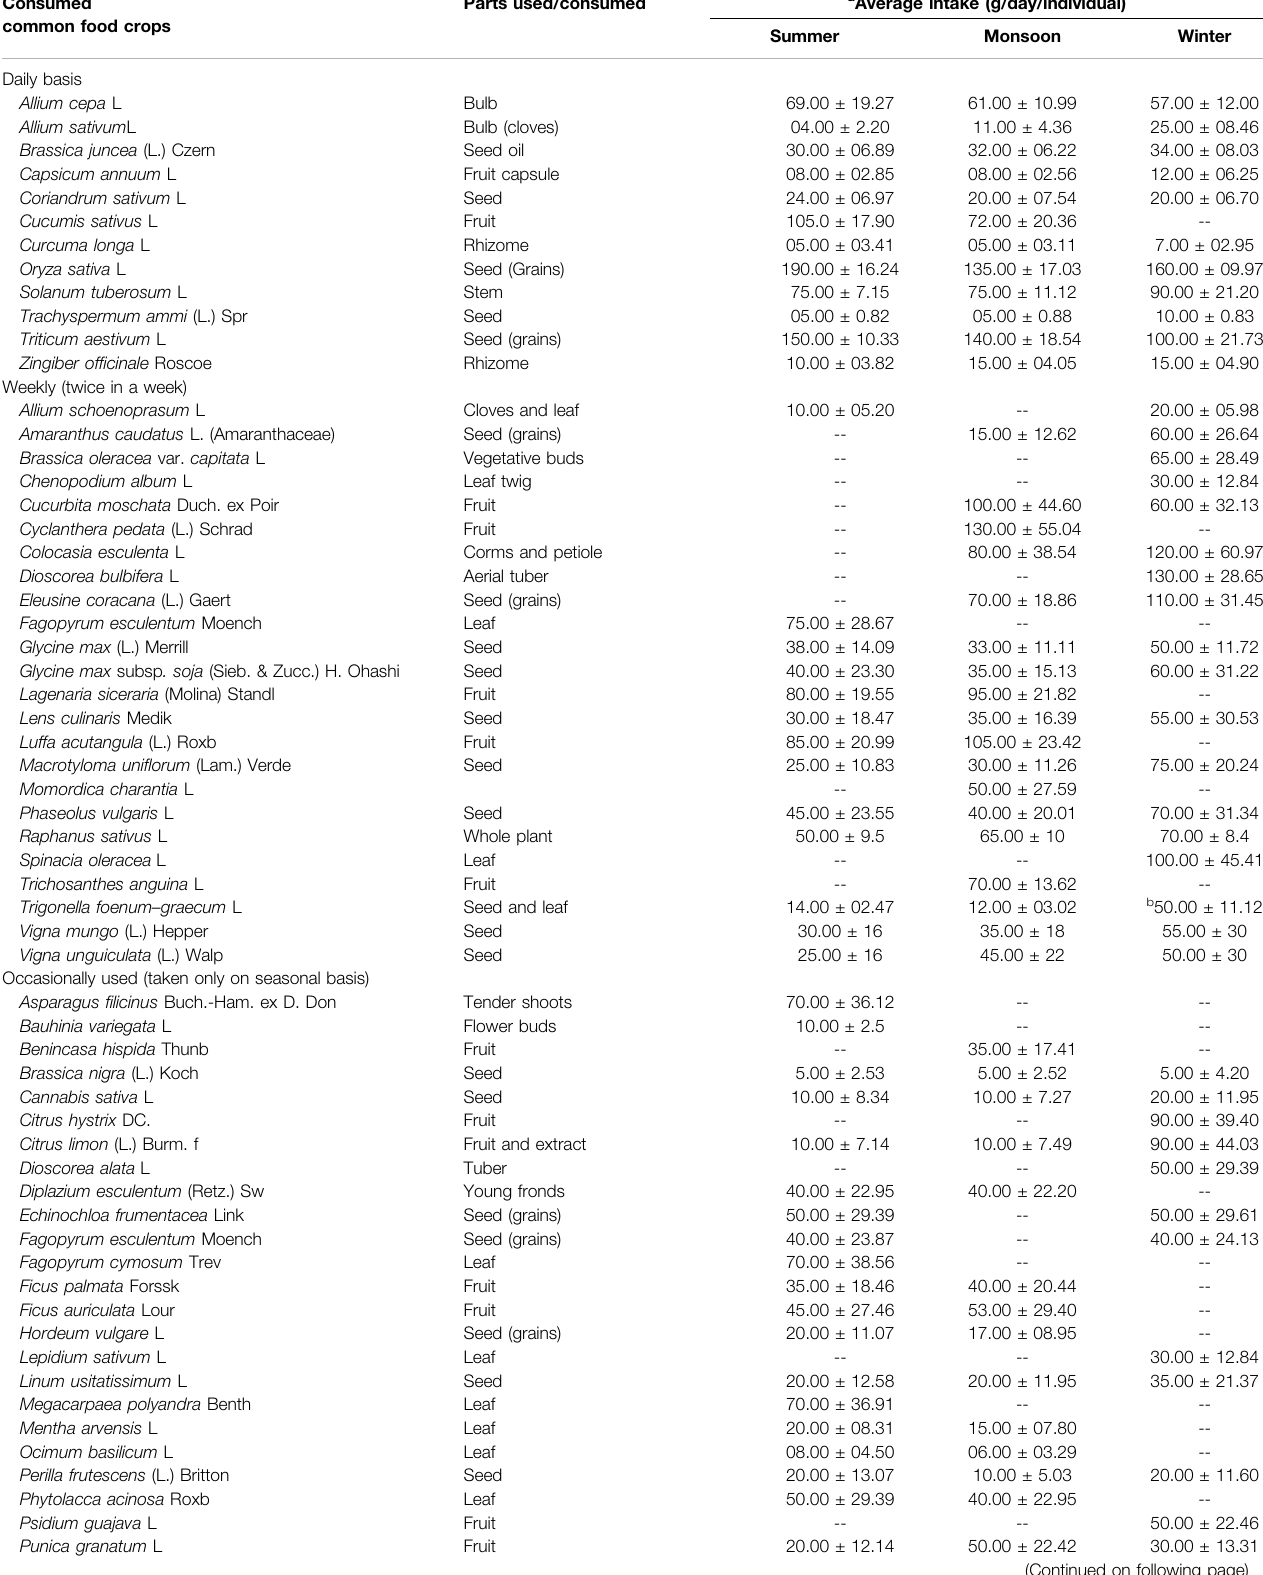
TABLE 2 | Mean daily, weekly, and rare intake of food crops in different